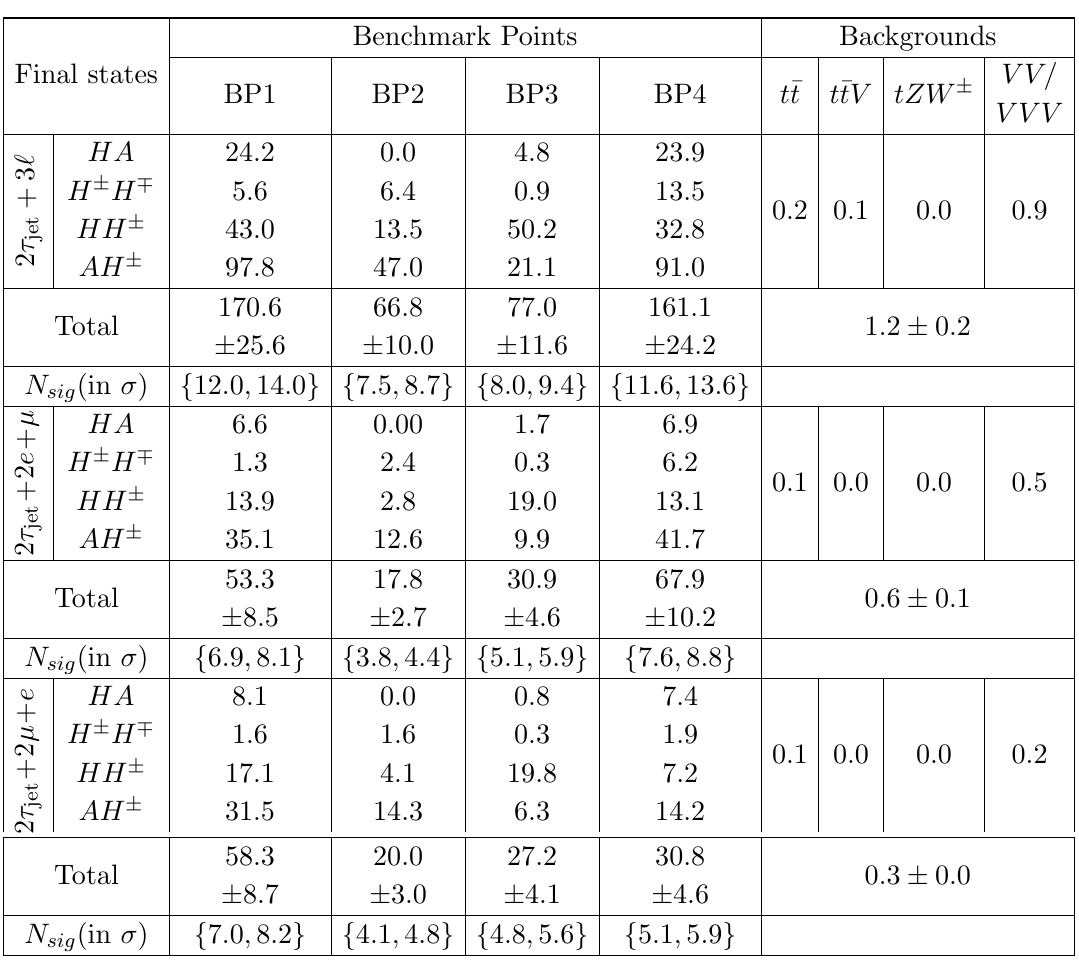
Table 8 . The number of events for 2 (cid:28) jet + 3 ‘ (cid:12)nal state at 100 fb (cid:0) 1 of integrated luminosity at the LHC with 14 TeV center of mass energy. The range for N sig is calculated incorporating the systematic uncertainties in signal and background events as well. The (cid:13)avour tagging ( e; (cid:22) ) has been